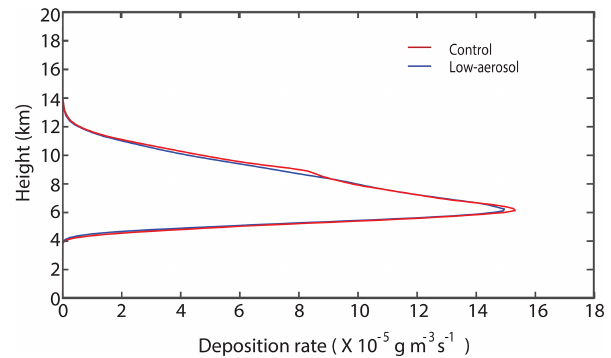
Figure 7. Same as Fig. 6 but for deposition